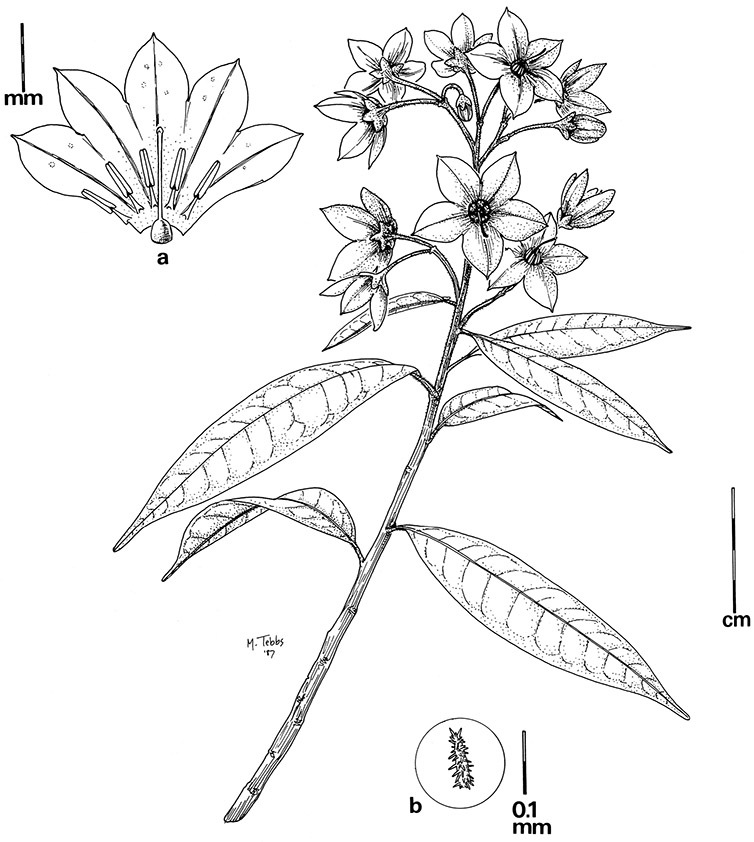
Solanum ruizii S. Knapp. (A–B drawn from Macbride 4351). Reproduced from Knapp (1989) with permission of the Natural History Museum Botany Library. Illustration by Margaret Tebbs.